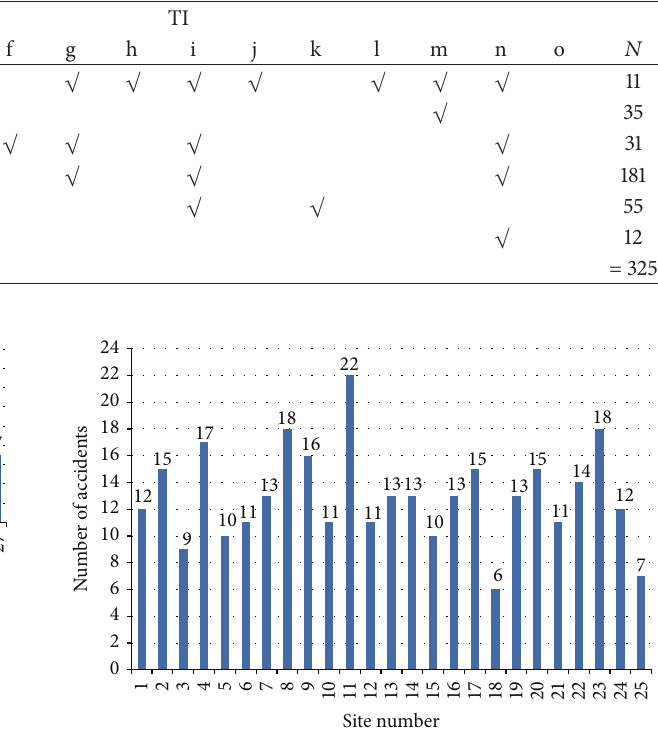
Figure 4: Number of accidents in large construction sites. Table 6: Comparative study on small and large construction